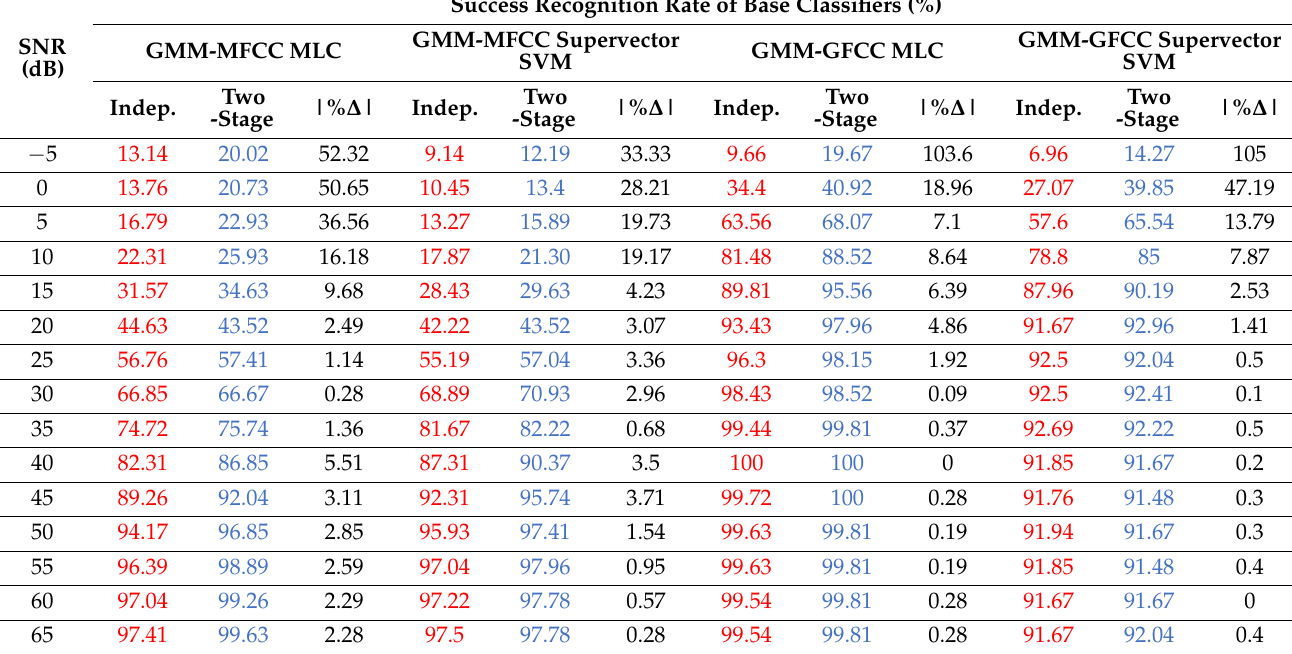
Table 3. Comparison of recognition rates for the base classifiers when they are used within the proposed system (blue) with that of the same base classifiers when they are used independently (red) on utterances distorted with street